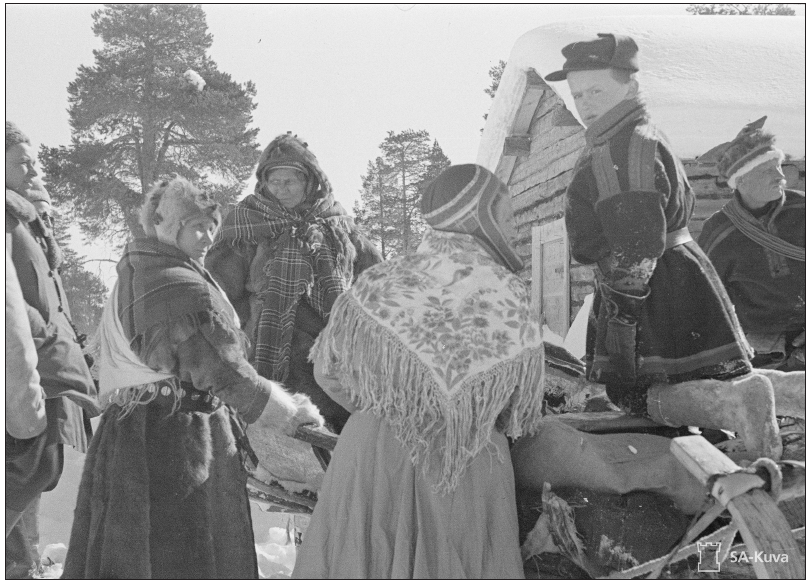
Figure 1: Wartime photograph from Vuotso. Original caption: “Lapps [sic] in Vuotso.” (Photographer unknown, SA-kuva, The Finnish Wartime Photograph Archive, 9926, April 14, 1940, http://sa-kuva.fi/